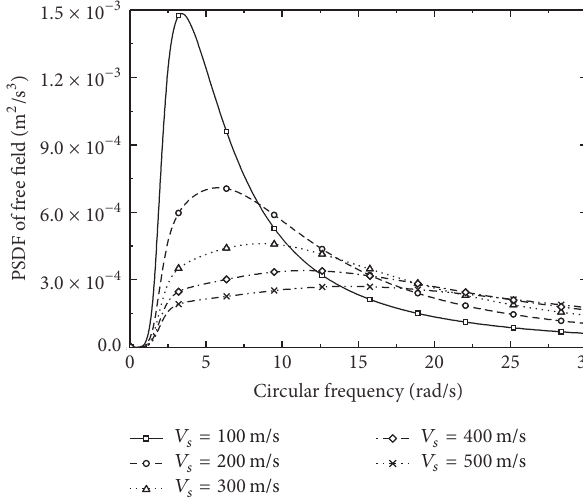
Figure 4: The PSDF of free field for different shear velocities of soil. the free field, primarily in the horizontal components. The rotational components are introduced as a result of variations in ground motion along the foundation due to inclined or incoherent waves. For simplifying the analysis, the kinematic interaction mechanism is considered as a low pass filter which reduces the translational component of the free-field motion but generates rocking and torsional component. If the propagating mechanism is considered as vertically propagat- ing plane shear waves only, the torsional component can be neglected. The Fourier amplitude relationships between the free-field displacement 𝑈 𝑓 𝑔 and the translational and rocking 𝑓 𝑈 𝑓 component (denoted as 𝑈 𝑟 , resp.) are simply ℎ and